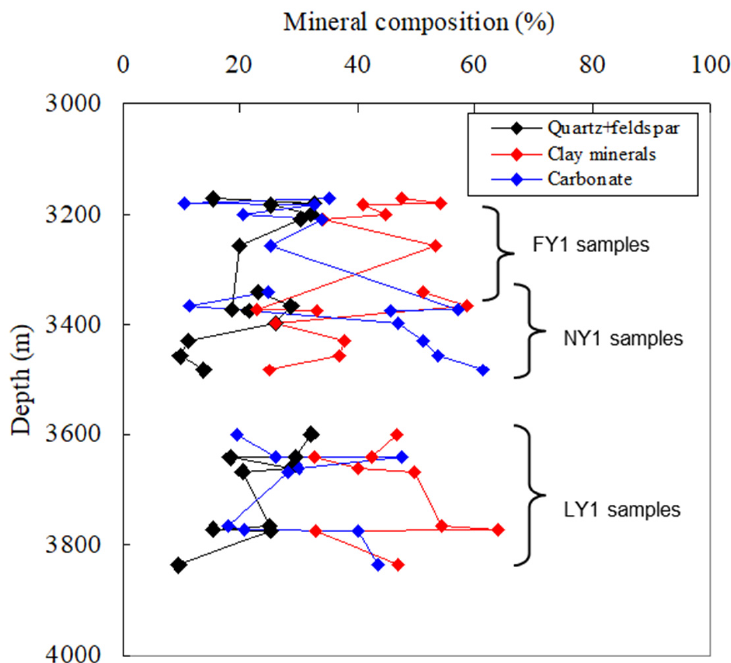
Figure 5. Variations of mineral compositions with burial depths for the studied samples. The mineral compositions of the three wells were basically similar, and they were mainly clay and carbonate minerals, quartz, and feldspar.